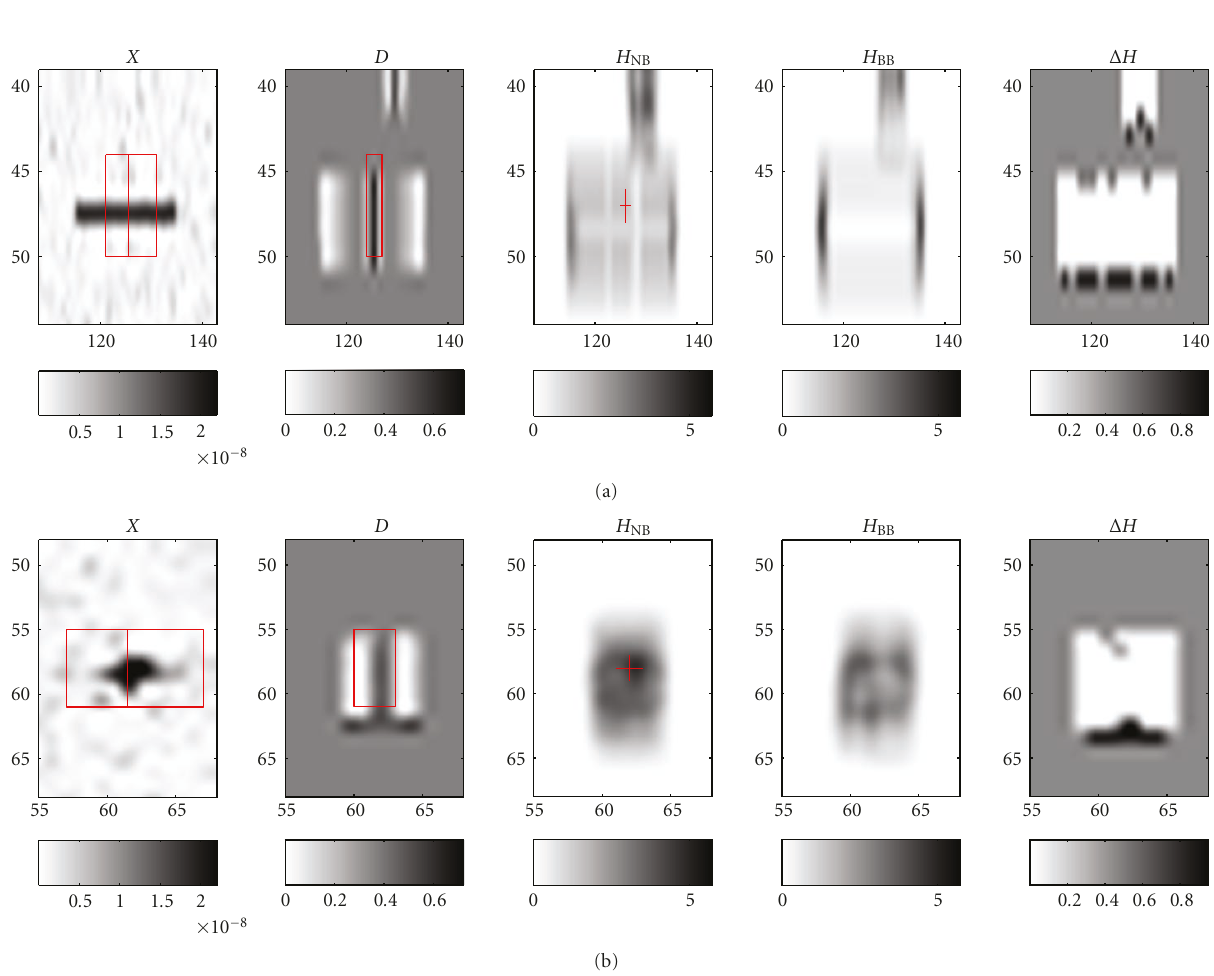
Figure 6: Local distribution power spectral density ( X ), dissimilarity D NB , entropies H NB and H BB and entropy di ff erence Δ (cid:13) H for the areas marked by black boxes in Figure 5(a). The upper row corresponds to the box covering a signal of interest at 7500 Hz, and the lower row corresponds to the interfering signal covered by the lower frequency. The two red rectangles and the red cross in the figure correspond to the TF windows needed for D test (leftmost panels), and H estimation (the second column from the left), respectively. Note that scaling in pixels is di ff erent for the upper and lower rows.